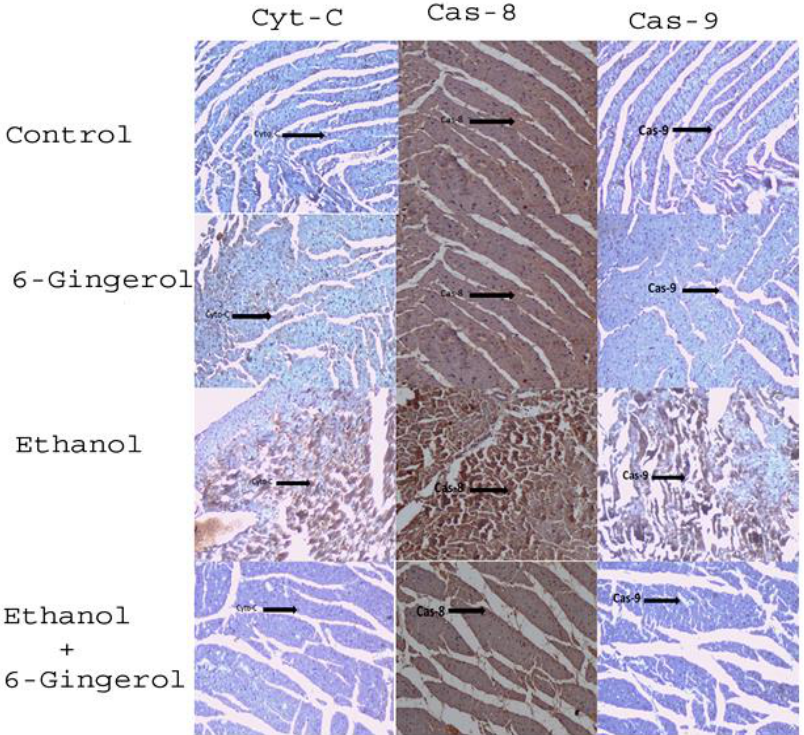
Figure 5. Six-gingerol regulates ethanol induced ROS-mediated apoptosis in cardiac tissue. Expressions of mitochondrial cytochrome C, caspase-8 and caspase-9 in cardiac tissues of control, 6-gingerol, ethanol and ethanol plus 6-gingerol groups. The arrow in each panel indicates the expressions of cytochrome C, caspase-8 and caspase-9 in respective groups.